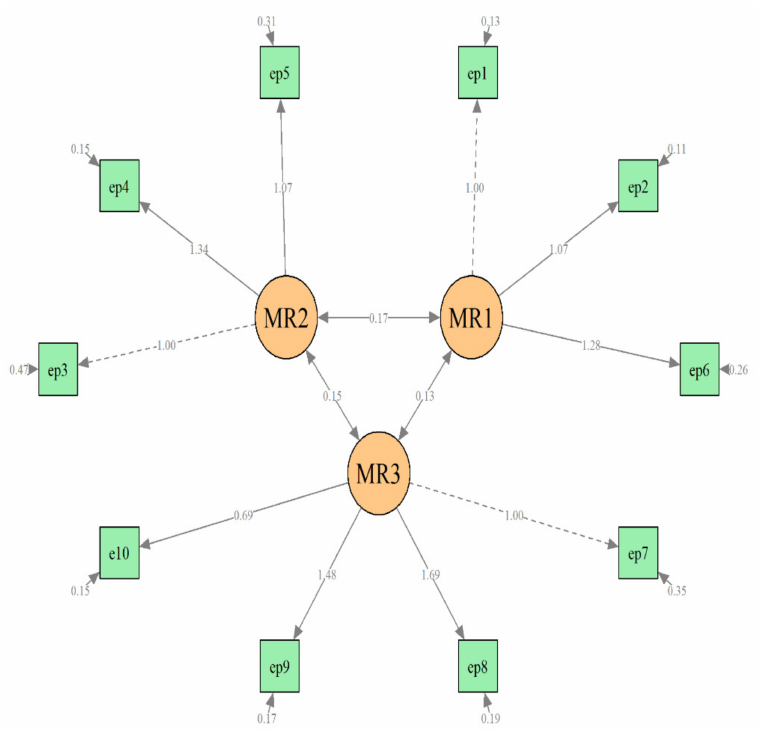
Figure 2. Confirmatory factor analysis of T2 data, 3-factor model (6–8 weeks